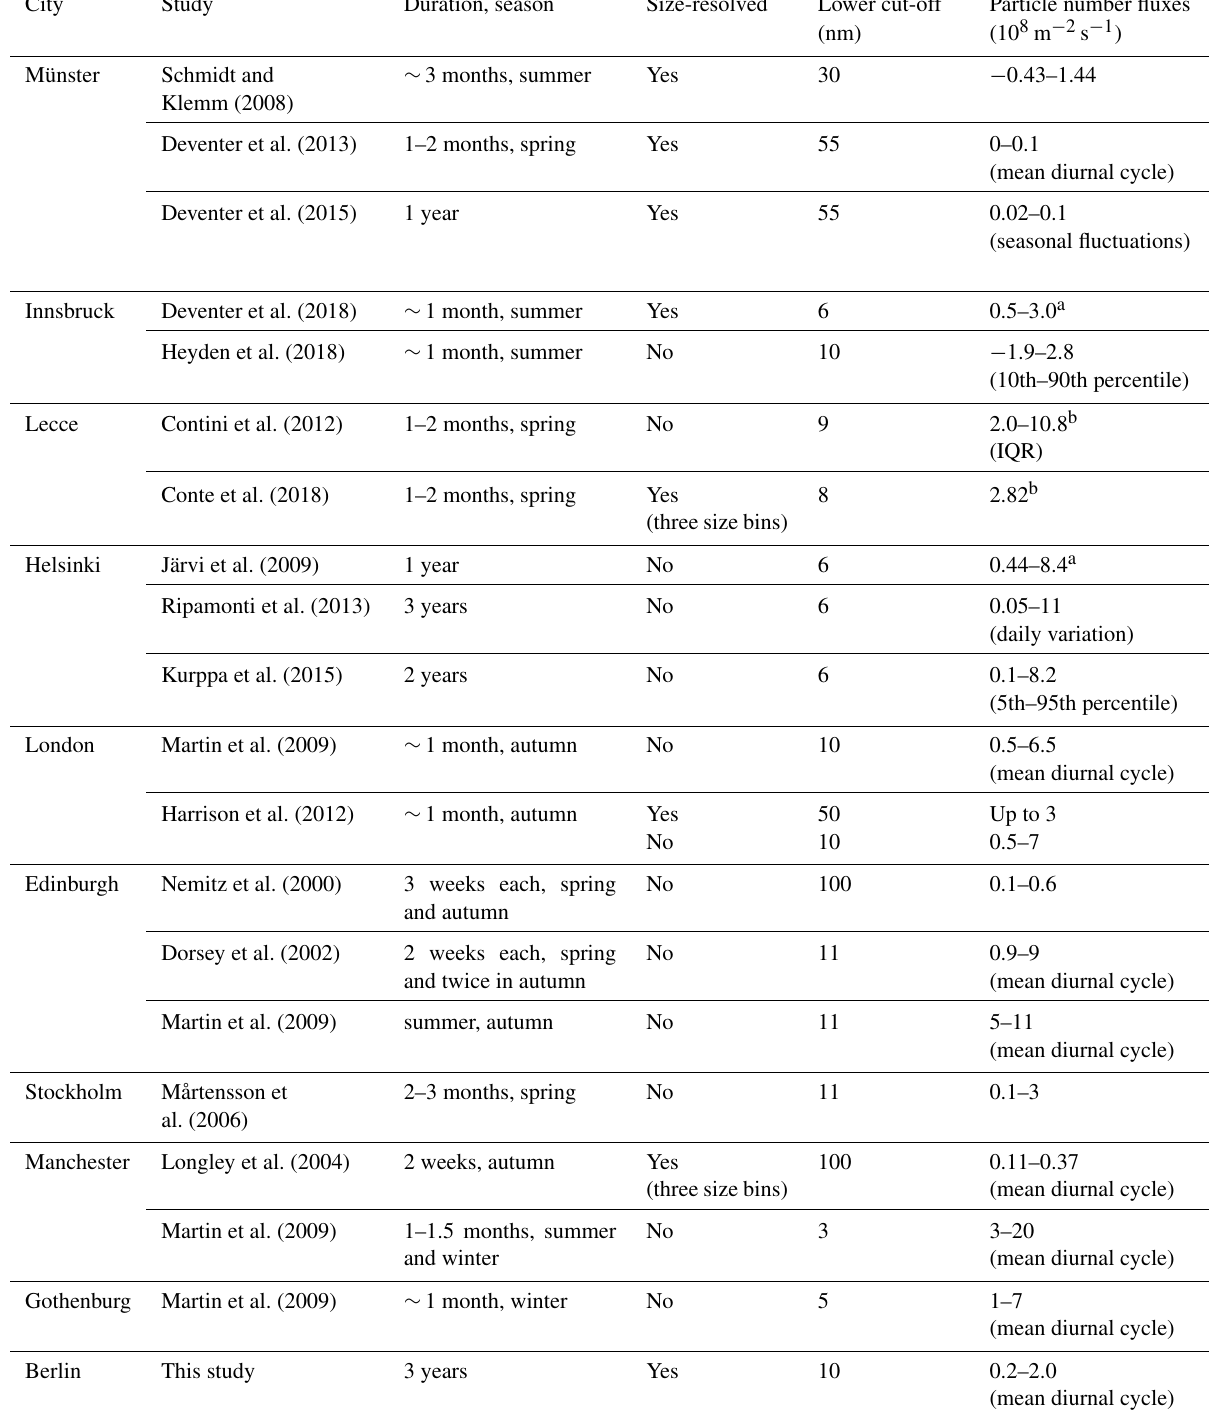
a Average daytime emission. b Measurement height of 14m (roughness